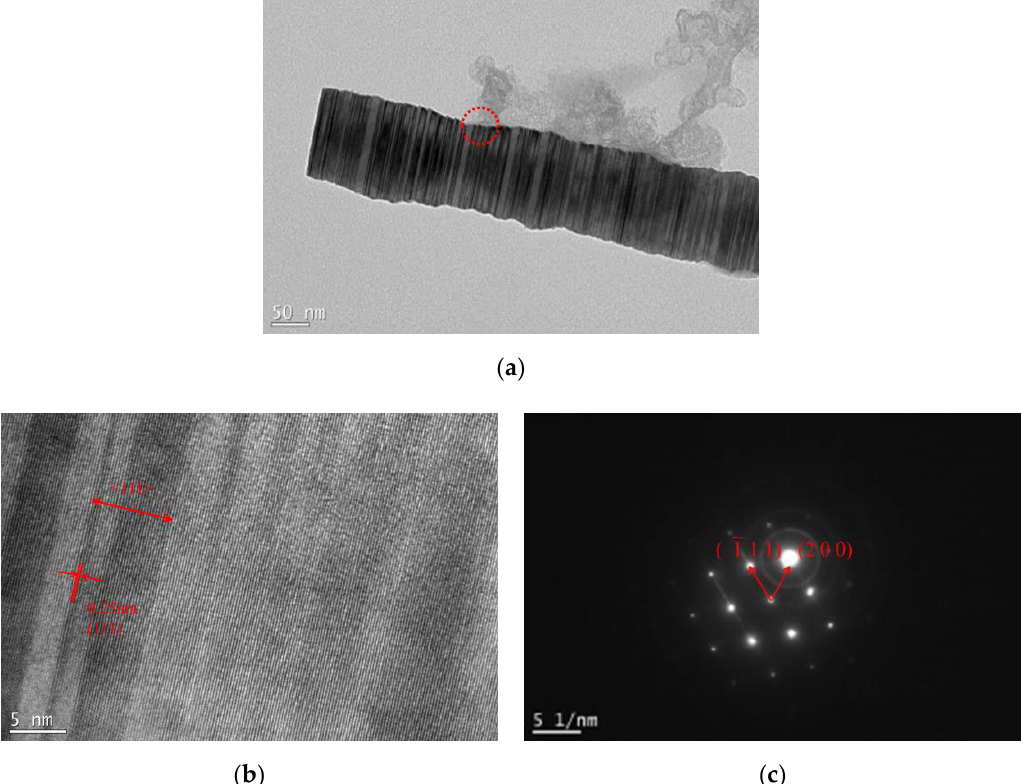
Figure 5. Microstructure of a single SiC whisker in sample ZS2: ( a ) transmission electron microscopy (TEM) image; ( b ) high-resolution transmission electron microscopy (HRTEM image); ( c ) selected area electron diffraction (SAED) image.